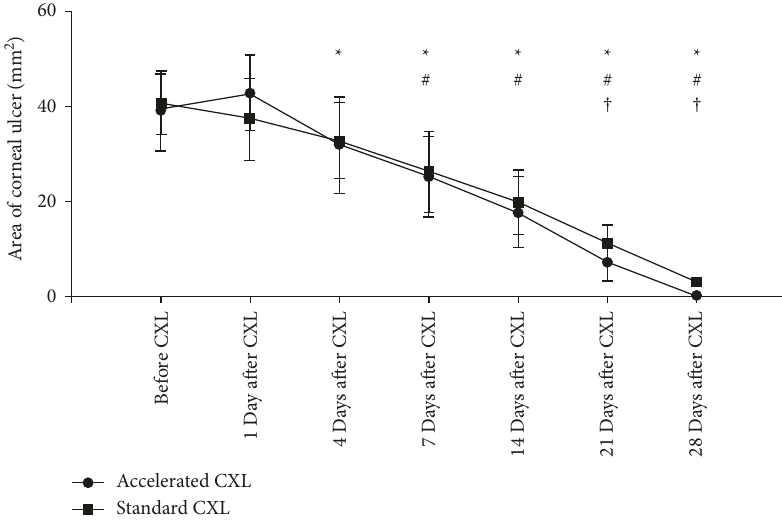
Figure 3: The area of corneal ulcer in two groups. each group compared with that before treatment ( differences in the areas of corneal ulcer between each group at one follow-up time point ( P